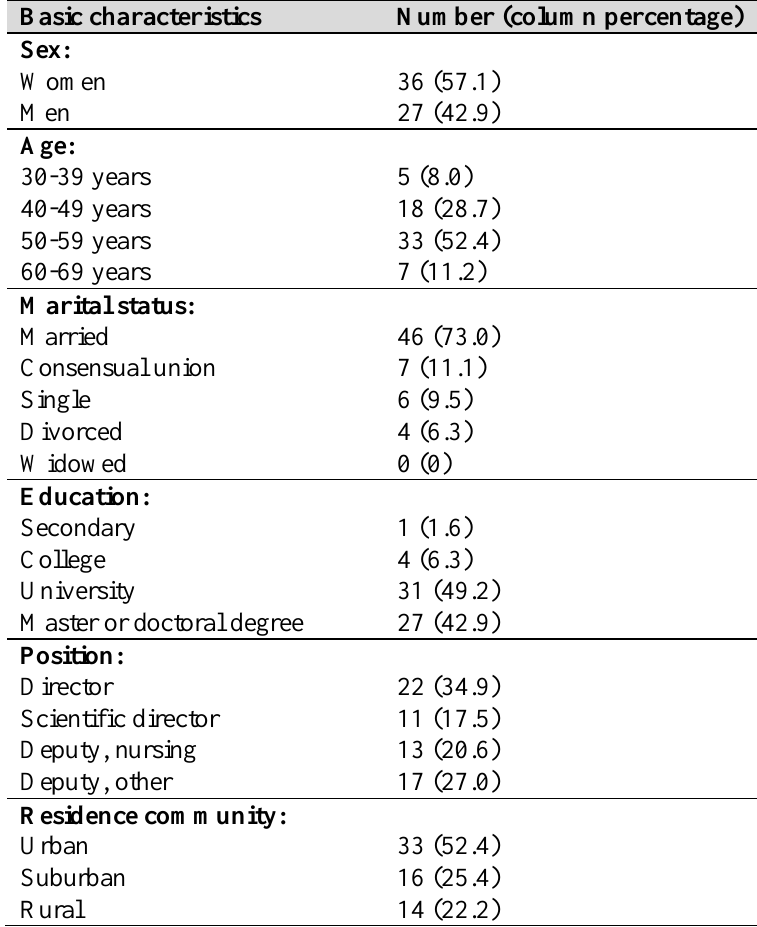
Table 1. Basic characteristics of study participants Basic